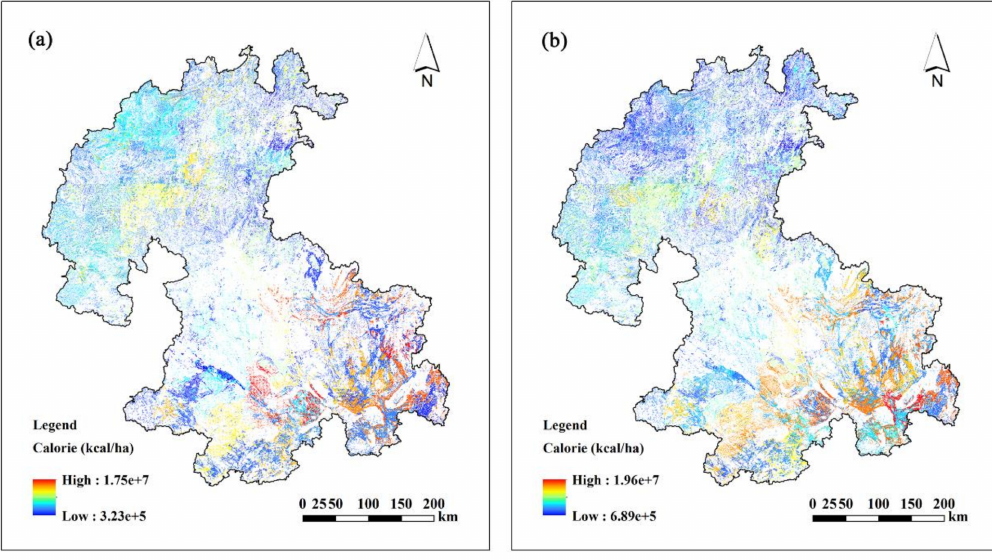
Figure 12. ( a ) The mixed grain crop calorie distribution in 2000; ( b ) The mixed grain crop calorie distribution in